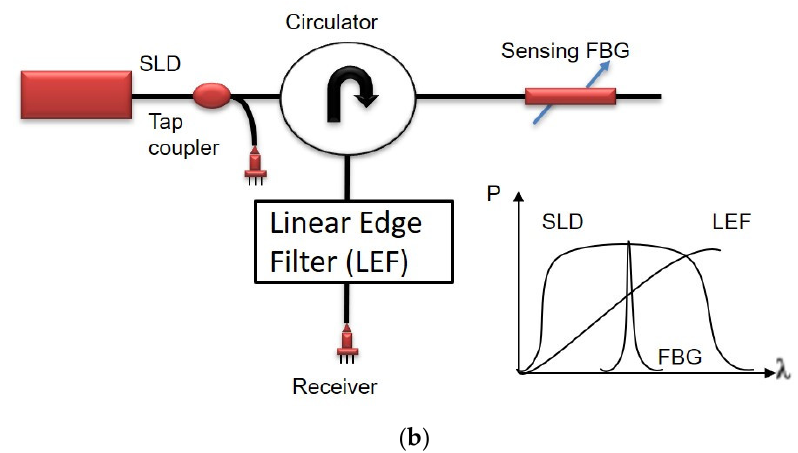
Figure 3. Optical circuits of ( a ) power detection method ( b ) edge filter method.